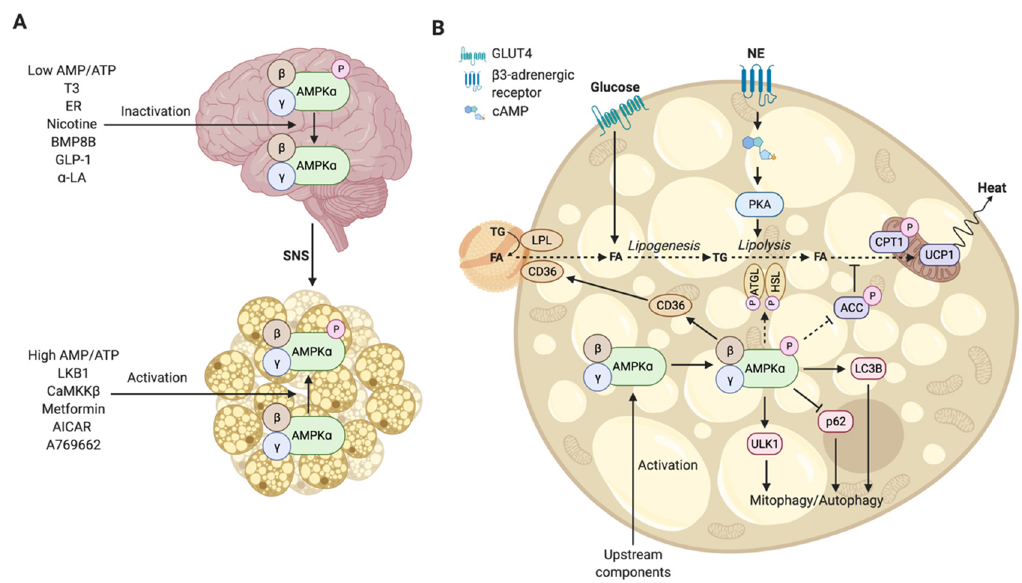
Figure 2. Schematic overview showing the functional mechanism of BAT activation mediated by AMPK. ( A ) Brain–AMPK–BAT axis, where BAT can be activated by inhibition of hypothalamic AMPK, after which the SNS will signal to BAT to upregulate lipolysis, or through direct activation mediated by different upstream components of AMPK. ( B ) Detailed overview of BAT activation through norepinephrine, excreted by the SNS, or through direct activation of AMPK. Norepinephrine can bind the β 3-adrenergic receptor, which will subsequently activate cAMP and PKA, ultimately increasing lipolysis and heat production. Upstream components of AMPK, previously described, activate AMPK after which CD36 is translocated to the membrane and LPL is stimulated, resulting in increased uptake of triglyceride-derived FA from lipoproteins and later in lipolysis combined with heat production. In addition, AMPK can release the inhibition of CPT1, increasing FA transport to mitochondria, also contributing to heat production, though this latter part of the signaling cascade is likely to only play a minor role in BAT thermogenesis. The role of AMPK in lipolysis and phosphorylation of ACC has not been proven experimentally; therefore, dashed lines are used in this figure. Abbreviations: acetyl–CoA carboxylase, ACC; 5-Aminoimidazole-4-carboxamide ribonucleotide, AICAR; alpha-lipoic acid, α -LA; adenosine monophosphate, AMP; AMP-activated protein kinase, AMPK; adipose triglyceride lipase, ATGL; adenosine triphosphate, ATP; bone morphogenetic protein 8B, BMP8B; cyclic AMP, cAMP; CaM-dependent protein kinase kinase beta, CaMKK β ; cluster of differentiation 36, CD36; carnitine palmitoyltransferase 1, CPT1; estrogen receptor, ER; fatty acid, FA; glucagon-like protein 1, GLP1; hormone-sensitive lipase, HSL; low-density lipoprotein, LDL; liver kinase B1, LKB1; protein kinase A, PKA; sympathetic nervous system, SNS; triglycerides, TG; triiodothyronine, T3; uncoupling protein 1,